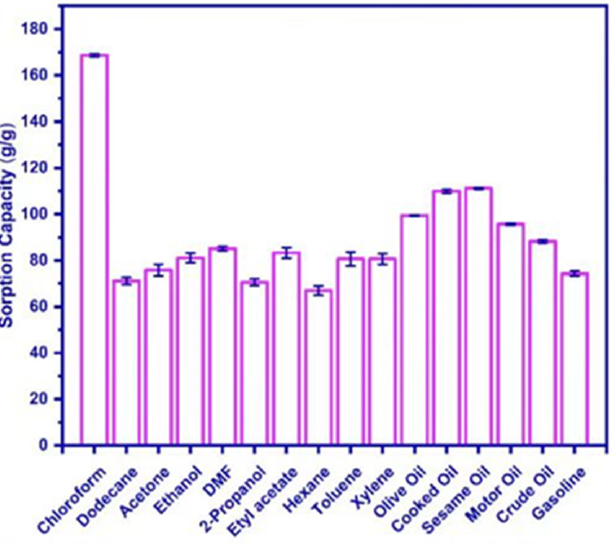
Figure 8. Adsorption capacity of silanized PVA/CNC aerogel [148] .